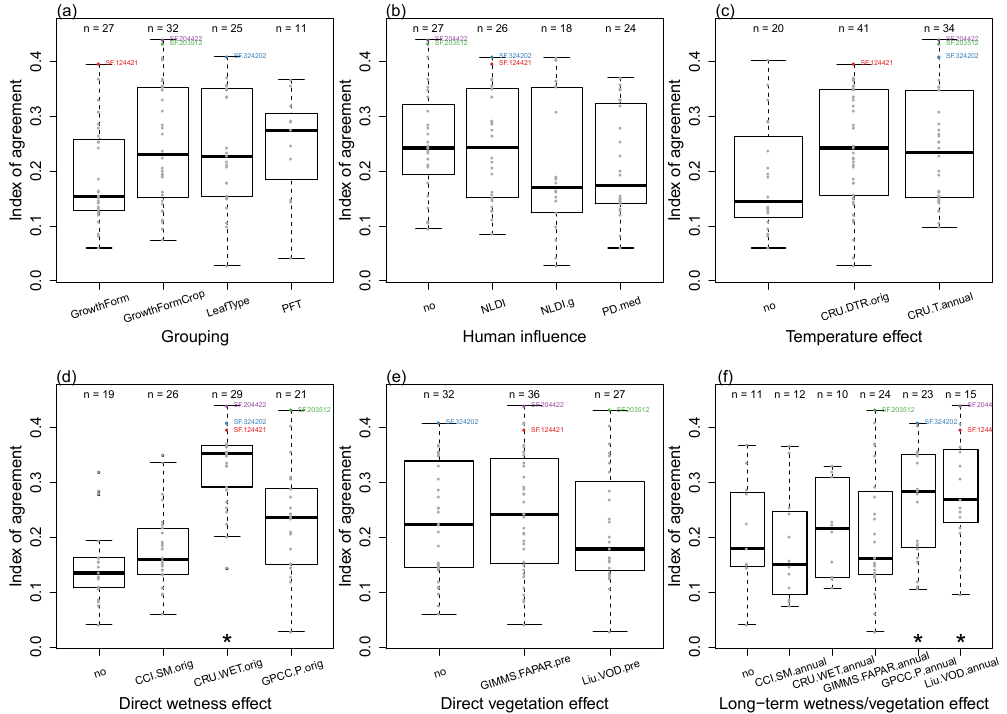
Figure 3. Effect of controlling factors and associated predictor variables in SOFIA models on the performance in simulating global monthly burned area dynamics. Performance is expressed as the index of agreement between simulated and observed (GFED) monthly burned area for the training data subset. Boxplots show the distribution of IoA based on all SOFIA model experiments that include the respective variable. Star symbols indicate a significantly higher IoA of a variable in comparison to the “no” group of each controlling factor (Wilcoxon rank sum test, p ≤ 0.05). Distribution of IoA depending on the used (a) land cover grouping scheme; and variables to account for (b) human influence; (c) temperature effects; (d) direct wetness effects; (e) direct vegetation effects; and (f) long-term wetness or vegetation effects. The best models (IoA>0.4 and AIC<200) are highlighted with coloured